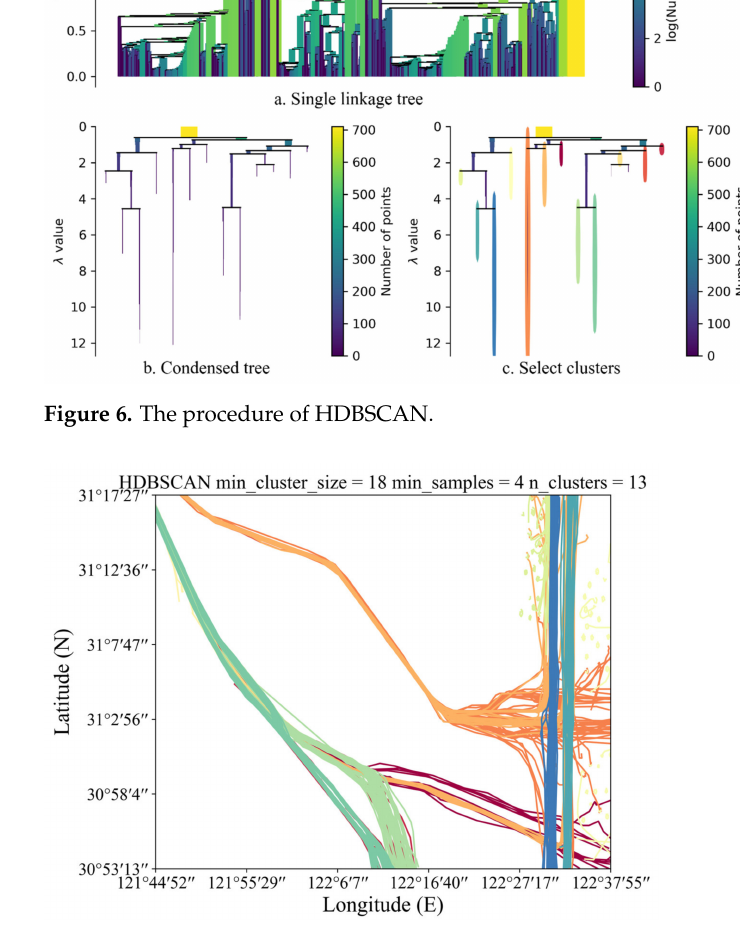
Figure 7. Results of HDBSCAN clustering of the ship